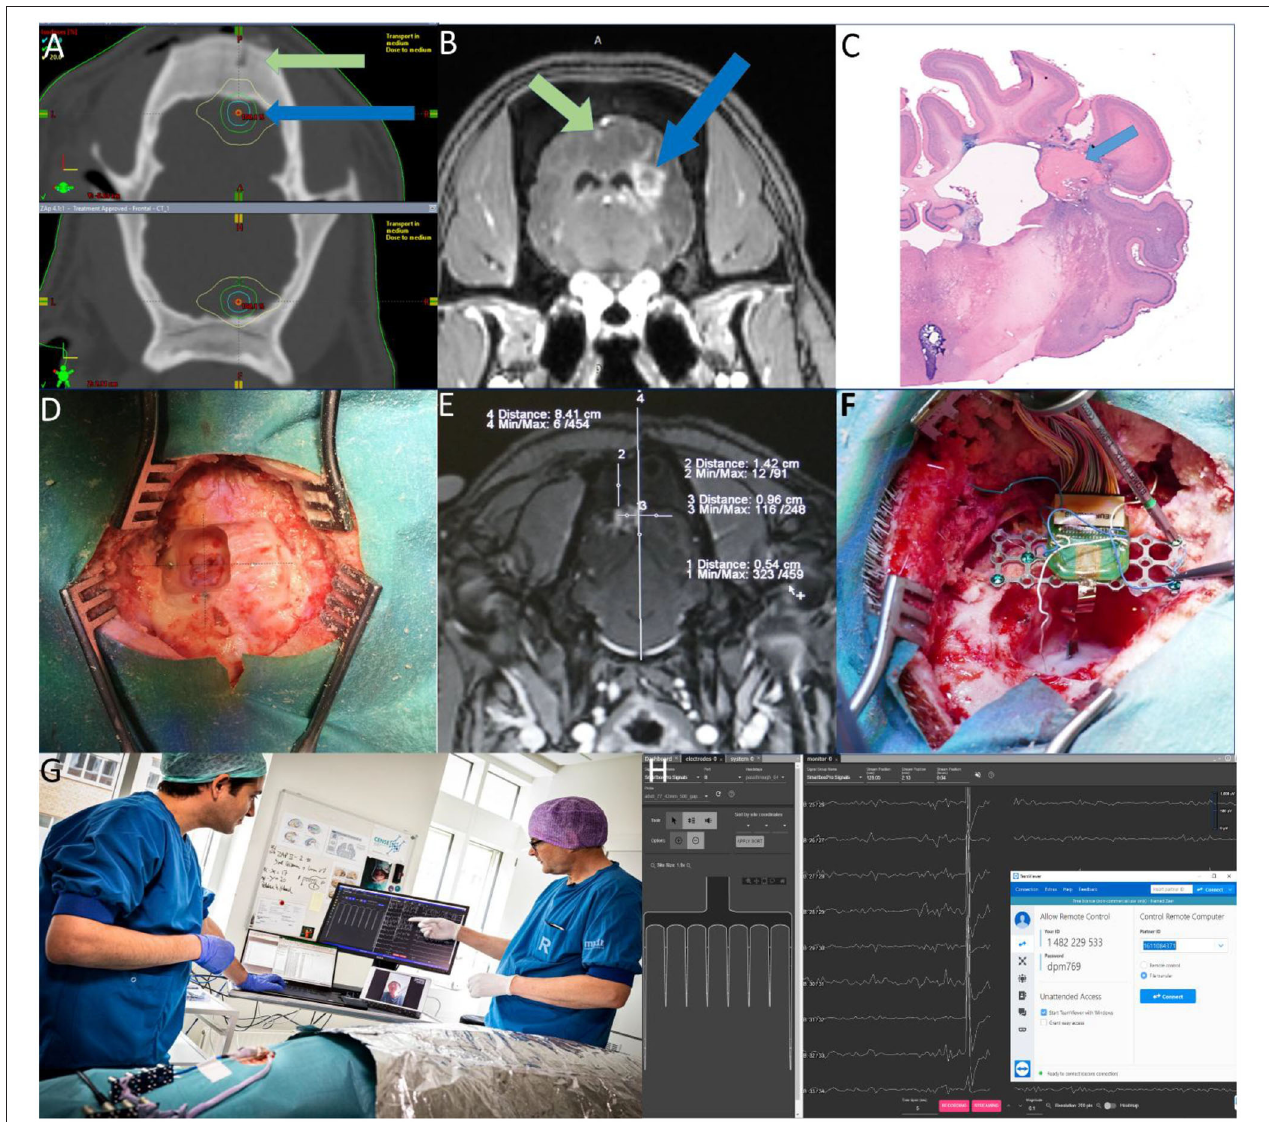
FIGURE 2 | (A) Targeting MRI-CT fusion- Green arrow: Plastic fiducial screw- Blue arrow: Target area (B) Radio-necrotic lesions Green arrow: left cortex—Blue arrow: right white matter (C) Histology of Necrotic lesion in white matter (D) Alignment of titanium screws on the target area. (E) Calculation of the target on the contrast MRI. (F) Inserting and fixating the probe and Omnetic connector (G) The Jumpers are connected to the head-stage connected to the PC and electrophysiology devices and the animal is under the faraday cage. The electrophysiologist is communicating with the surgeons and controlling the electrophysiology software remotely (Photo by Tonny Foghmar). (H) Screenshot showing a schematic of the BCI chip implanted in the visual cortex and the stream of the electrophysiological activity in the Allego software with TeamViewer on top.